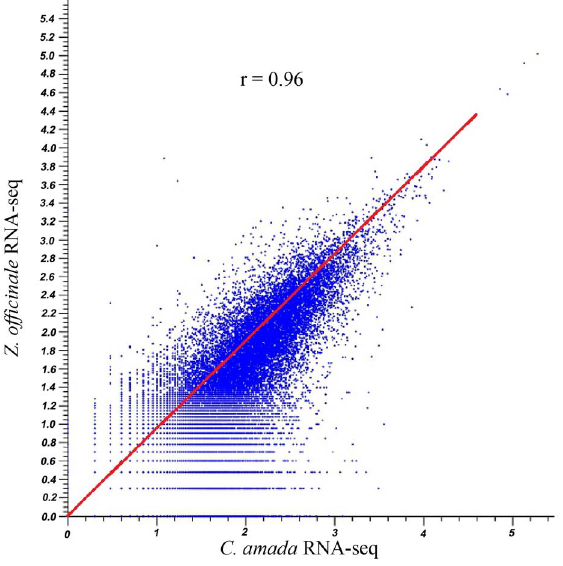
Figure 5. Pearson’s correlation coefficient between C.amada and Z.officinale transcriptomes. Comparisons of estimated RPKM distributions between C. amada and Z. officinale and R. solanacearum interactions. Pearson’s correlation coefficients ( R 2 ) between transcrip- tomes are presented.